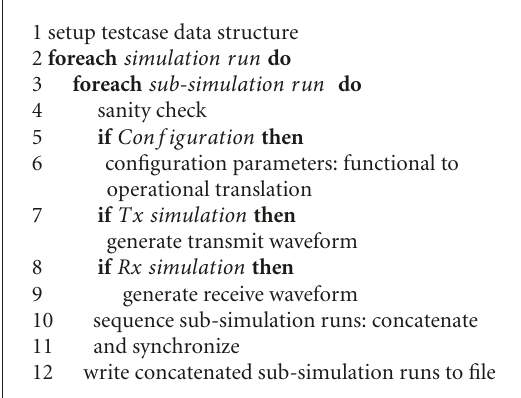
Algorithm 1: Stimuli Generation